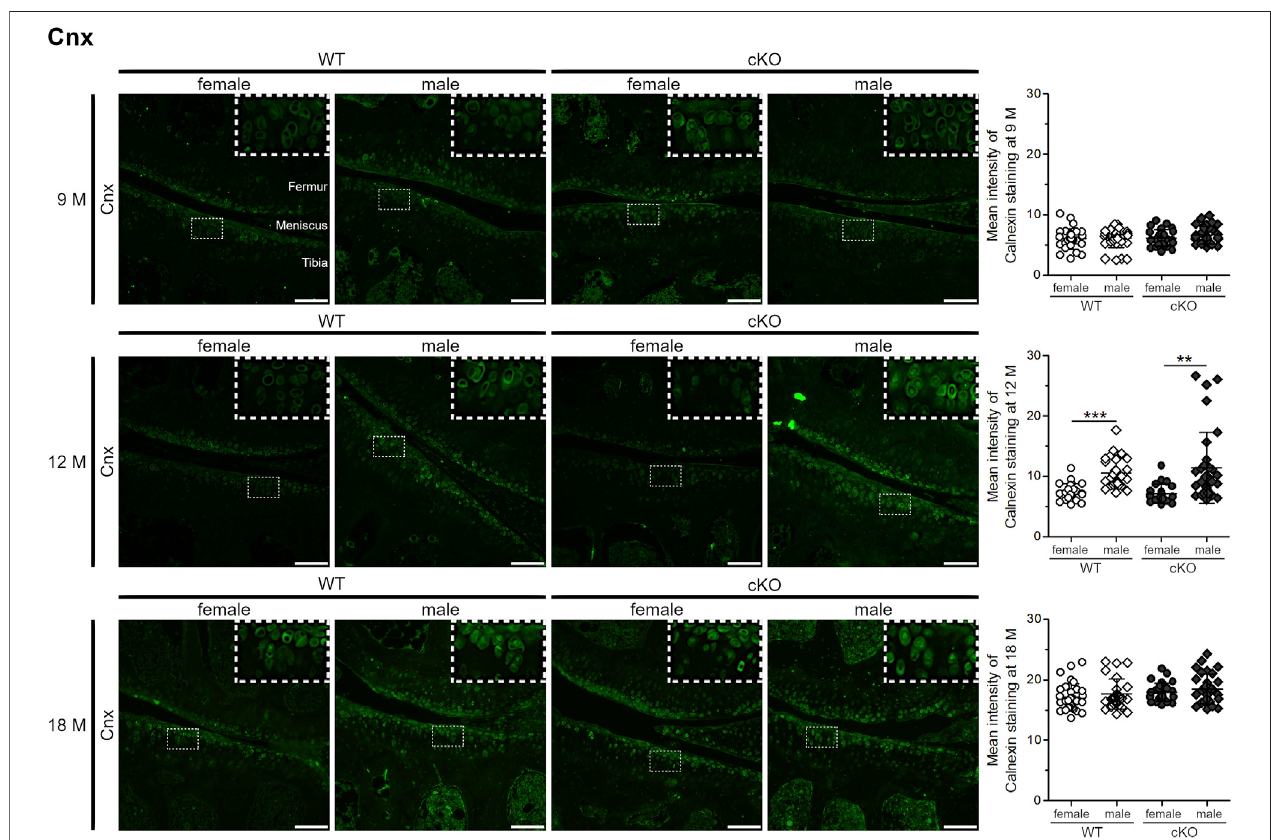
FIGURE 3 | Age-related ER stress increases in articular chondrocytes at a slower rate in female mice than in male mice. 9-month-old knee cartilage of WT and ERp57 cKO mice reveals very low levels of the ER stress marker calnexin (Cnx) with no differences between genotypes and gender. At the age of 12 months, knee sections of male WT and ERp57 cKO mice disclose a higher immuno fl uorescence staining intensity of Cnx compared to female samples (male WT to female WT: p = 0.0000003; male cKO to female cKO: p = 0.0018094). At the age of 18 months, the overall calnexin staining intensity increased, but is comparable between the analyzed groups. Representative image sections were marked and shown 3-fold enlarged in the upper right corner. Scale bars = 100 µm. M = months, Cnx = Calnexin.